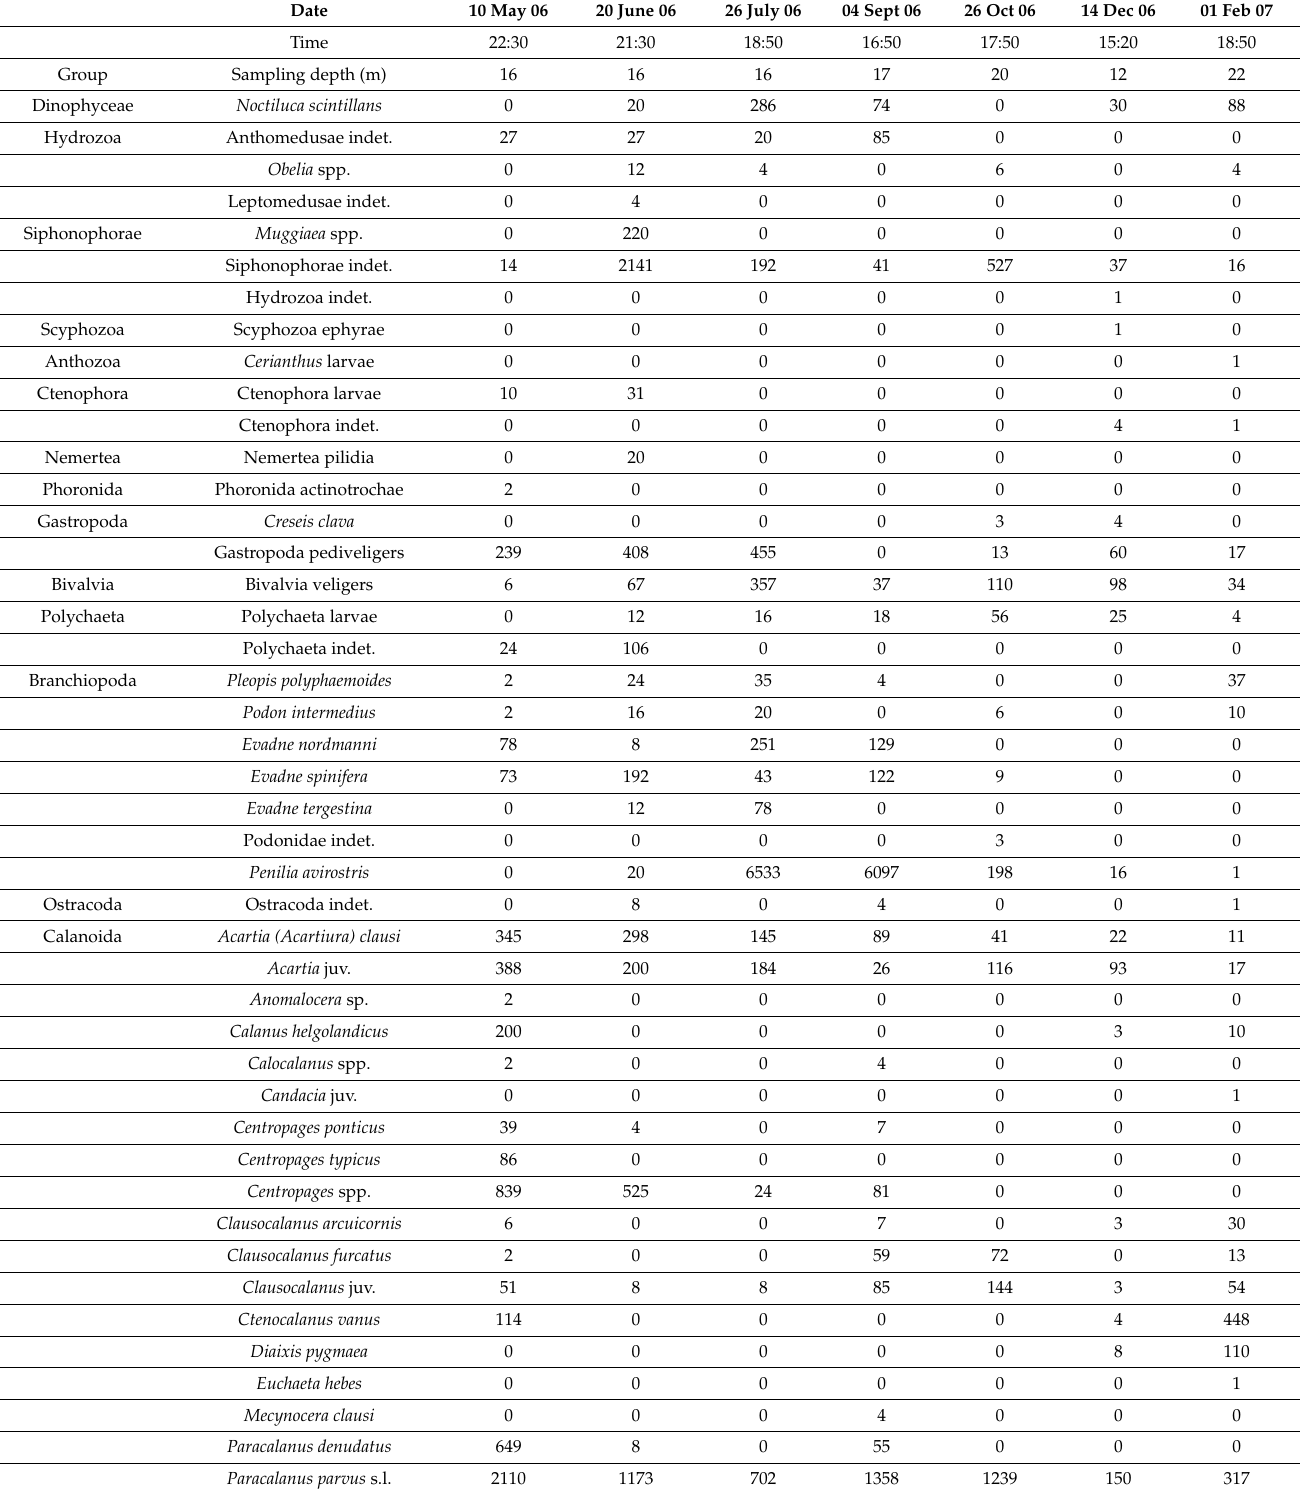
Table A2. Mesozooplankton abundance (ind m − 3 ) and species composition during the studied period: from May 2006 to February 2007. Zooplankton samples were collected at the same time